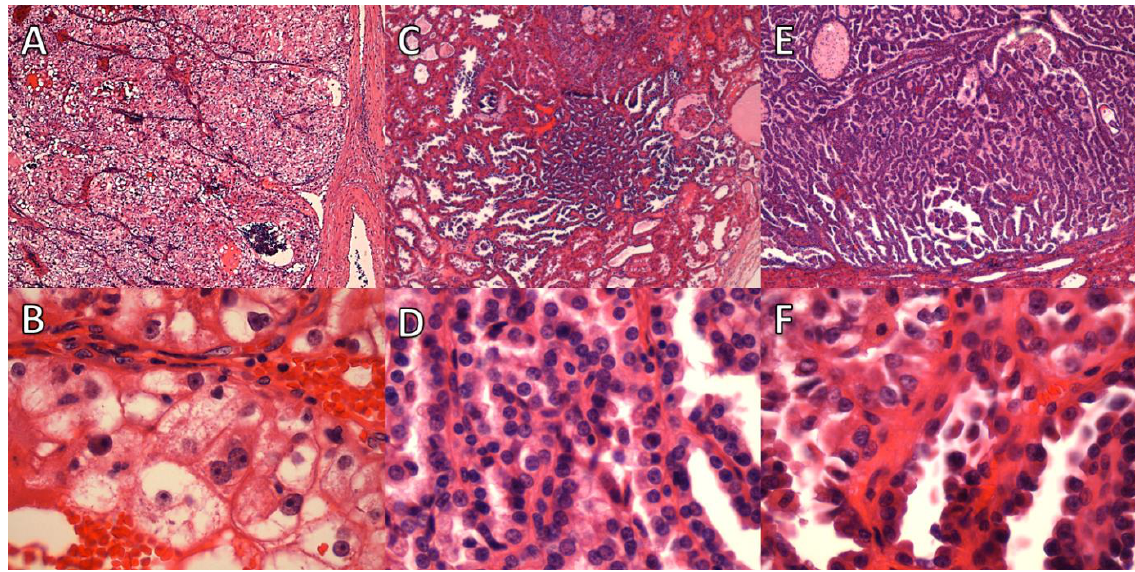
Figure 3. Case 1: A and B . Clear-cell renal cell carcinoma, grade 3; high- and low-power fields of the two papillary adenomas are shown in C and D and E and F